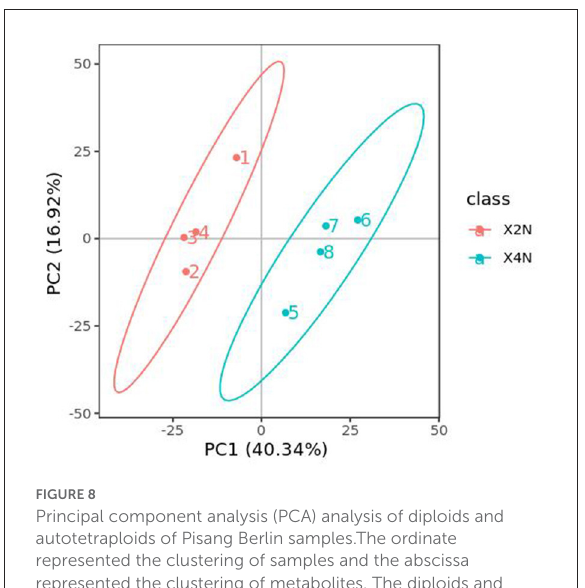
FIGURE8 Principal component analysis (PCA) analysis of diploids and autotetraploids of Pisang Berlin samples.The ordinate represented the clustering of samples and the abscissa represented the clustering of metabolites. The diploids and autotetraploids of Pisang Berlin were represented as following, X2N represented diploids of Pisang Berlin (1, 2, 3, and 4 represented sample replicates), X4N represented autotetraploid of Pisang Berlin (5, 6, 7, and eight represented sample